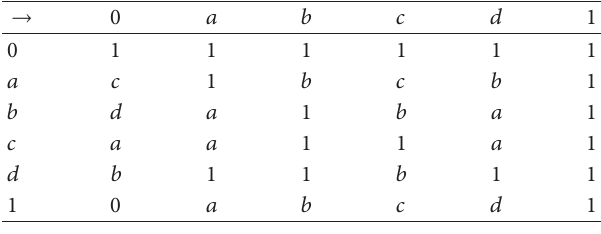
Table 1: The implication operator of 𝐿 = {0,𝑎,𝑏,𝑐,𝑑,1} .